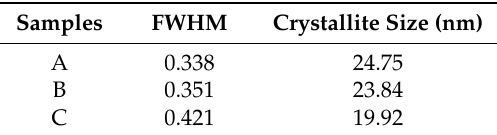
Figure 4. XRD patterns of ZnCo 2 O 4 samples synthesized with ( A ) 5.4; ( B ) 10.8; and ( C ) 16.2 mmol of dodecylamine. The peak signals for the ZnCo 2 O 4 structure (JCPDF 23-1390) are labeled with black-filled circles. Table 1. Crystallite size of the ZnCo 2 O 4 samples.